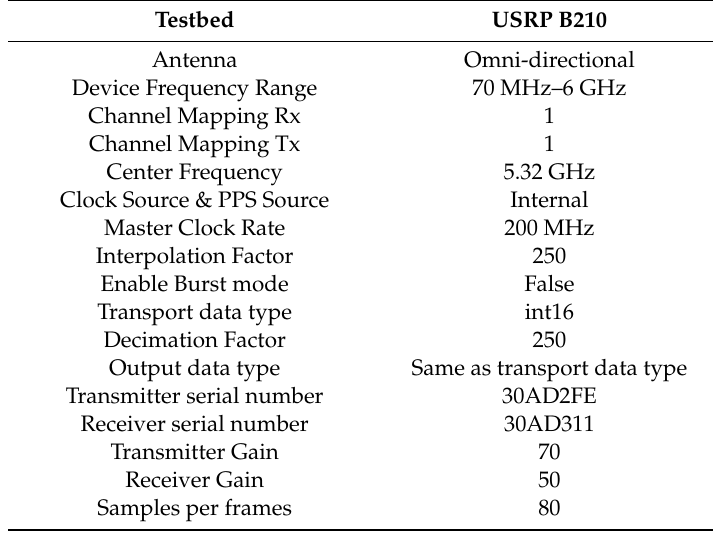
Figure 1. Non-contact sensing testbed architecture. Table 2. Hardware parameters.